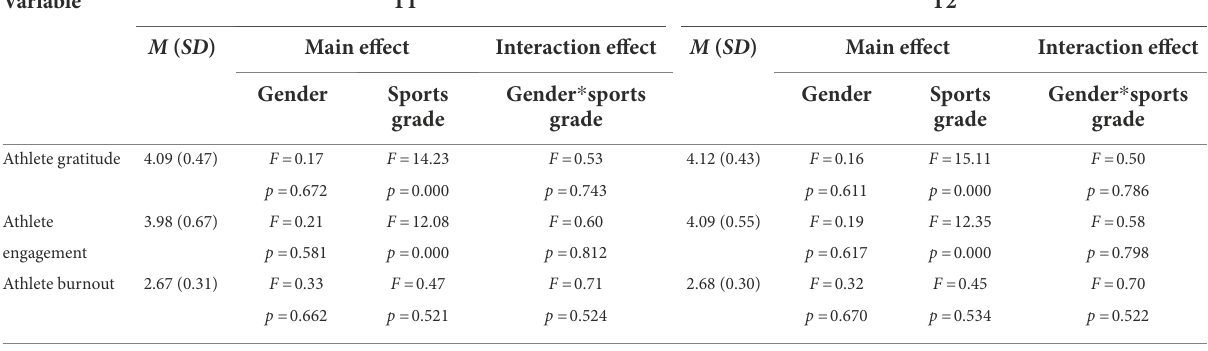
TABLE 3 Biased correlation analysis of each variable.